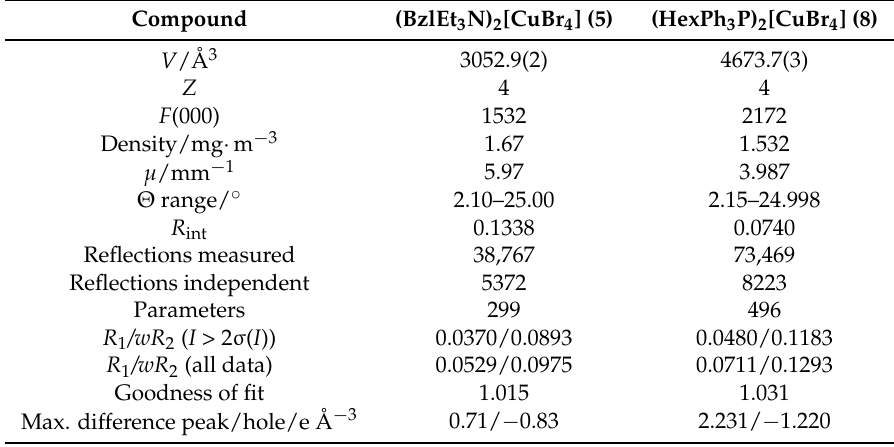
Table 2. Selected bond lengths and bond angles of (BzlEt 3 N) 2 [CuBr 4 ] ( 5 ).